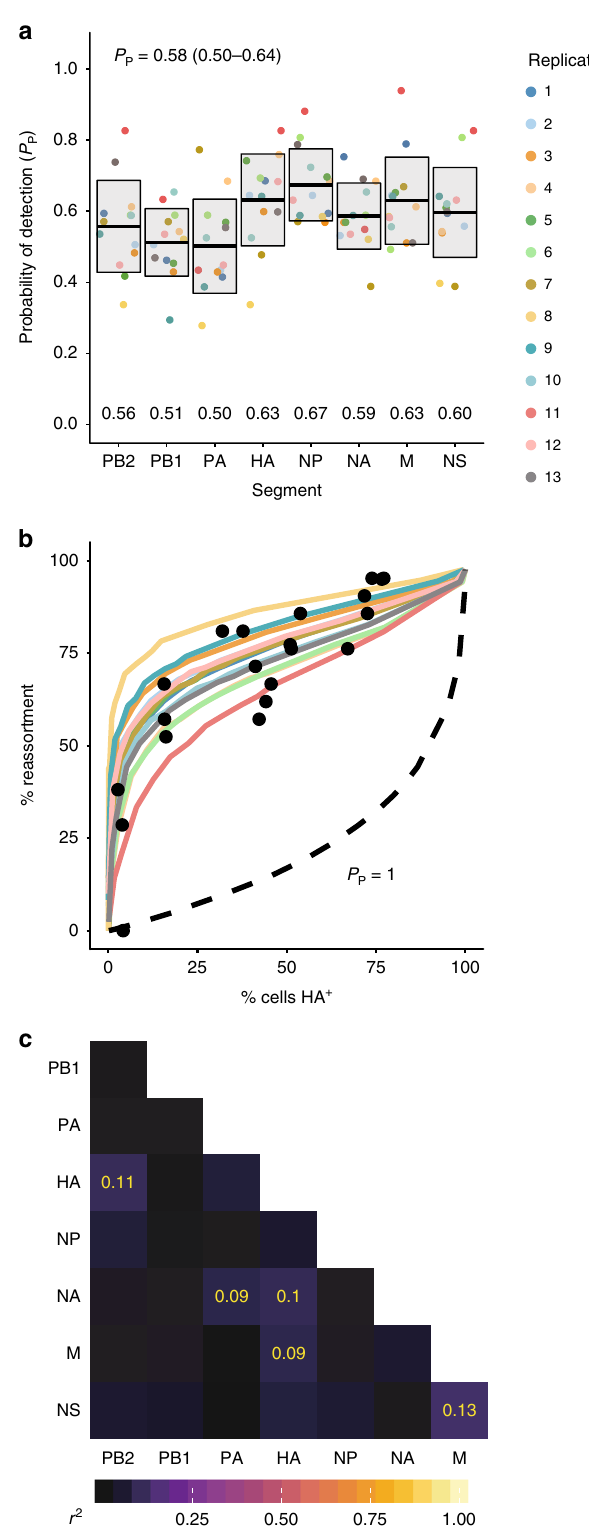
segment-speci fi c values to re fl ect the fact that productive infec- tion requires independent delivery of all eight genome segments. Using this assay, the P P , i values for each segment of Pan/99 virus were quanti fi ed (Fig. 1a). We observed that each segment was present at an intermediate frequency between 0.5 and 0.7, indicating that IVGs may arise from loss of any segment(s).